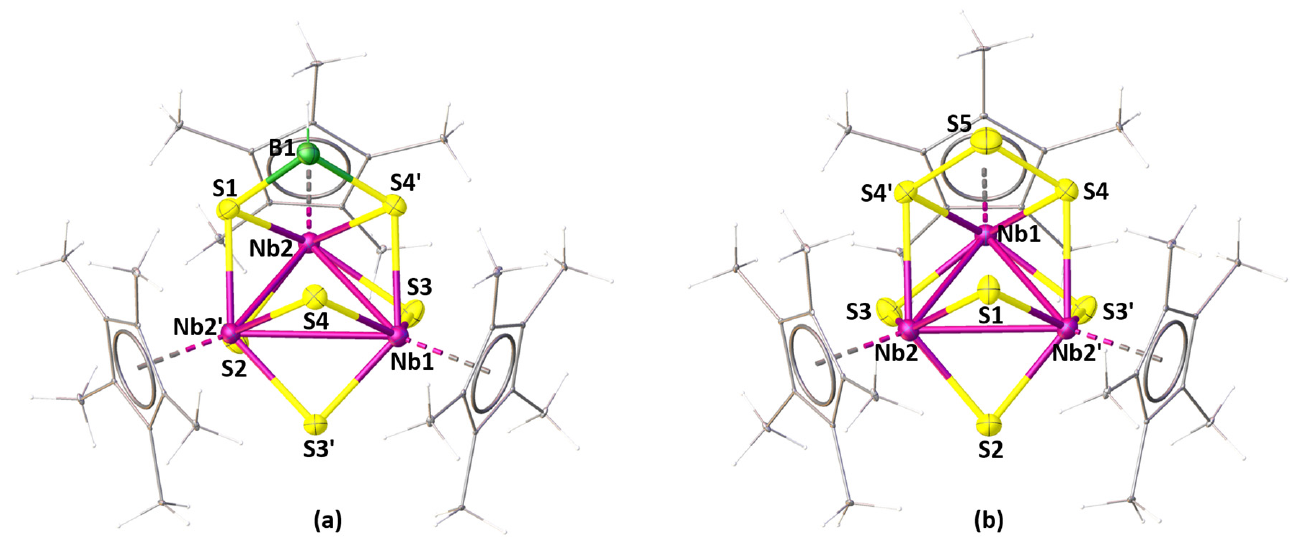
Figure 2. Molecular structures and labelling diagrams of 3 ( a ) and 4 ( b ). Selected bond lengths (Å) and angles (deg) in 3 : Nb1-Nb2 3.242, Nb2-Nb2 ′ 3.006, Nb1-S4 ′ 2.532(2), Nb2-S1 2.412(2), S1-B1 2.23(3), S4 ′ -B1 2.18(3); Nb2 ′ -Nb2-Nb1 62.38, Nb2-Nb1-Nb2 ′ 55.25, Nb1-S4 ′ -Nb2 77.51(6), S4 ′ -B1-S1 94.0(11); in 4: Nb1-Nb2 3.242, Nb2-Nb2 ′ 3.006, Nb2-S4 ′ 2.644(2), Nb1-S4 2.532(2), S4-S5 2.093(3); Nb2-Nb1-Nb2 ′ 55.25, Nb2-S1-Nb2 ′ 77.08(10), S4-S5-S4 ′ 93.46(18).